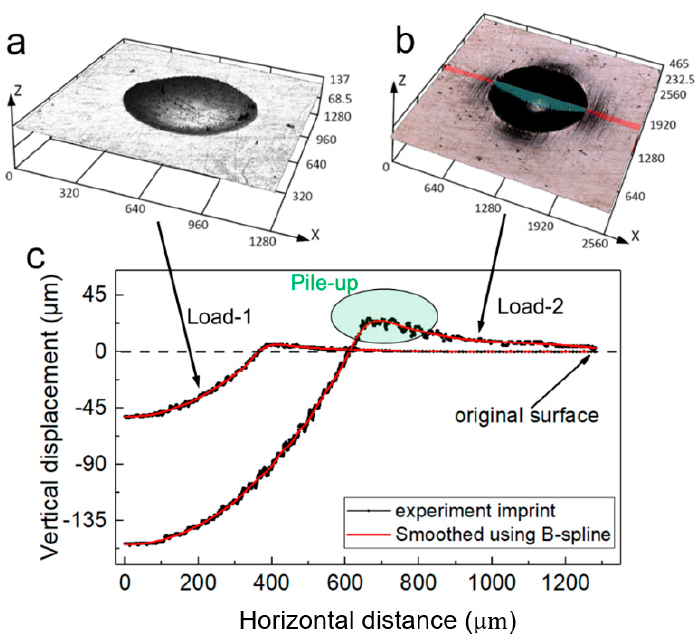
Figure 3. The measured indentation imprints using a laser confocal microscope: ( a ) imprint map- ping under indentation Load-1; ( b ) imprint mapping under indentation Load-2; ( c ) corresponding 2D imprint snapshots (unit: µm).